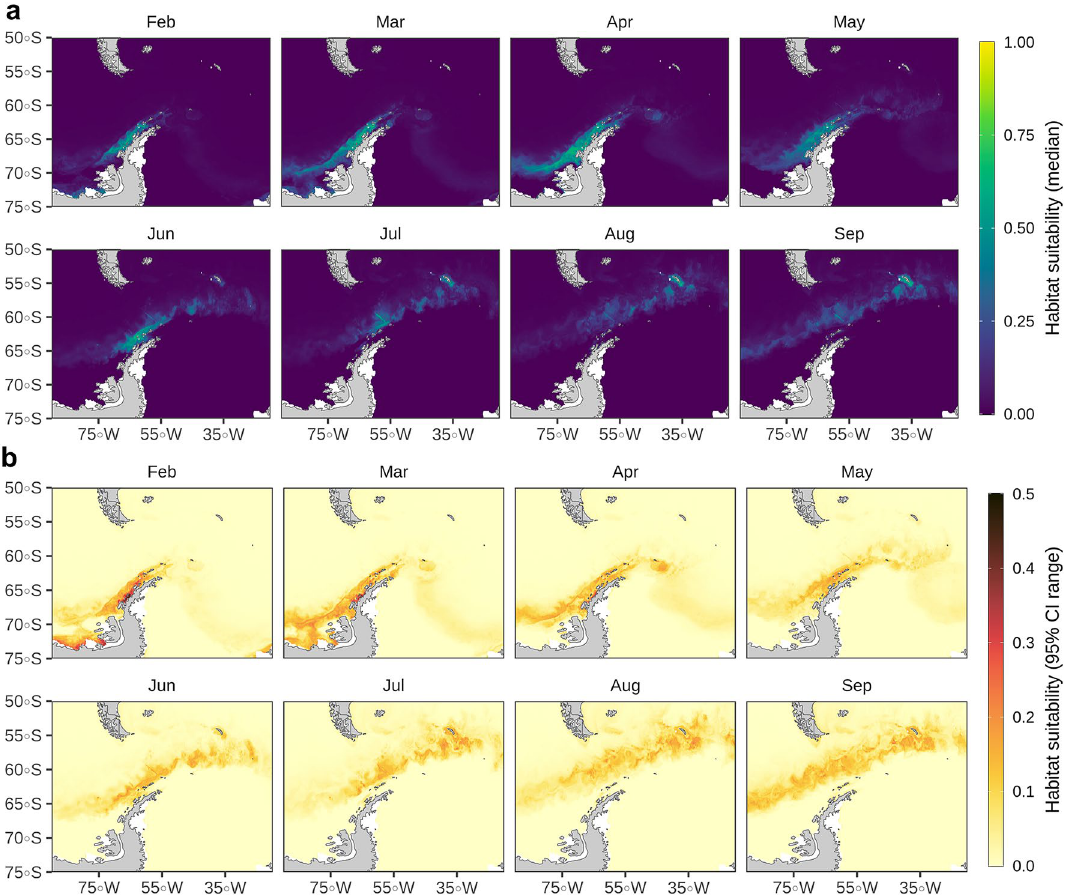
Figure 7. Predicted habitat suitability of juvenile and sub-adult Antarctic fur seals for February—September 2019. ( a ) Monthly average of daily predictions (median of the bootstrap predictions, n = 50). ( b ) Monthly average of daily uncertainty estimates (95% confidence interval range of the bootstrap predictions, n = 50). Maps were generated using R version 4.0.2 (https:// www.r- proje ct.